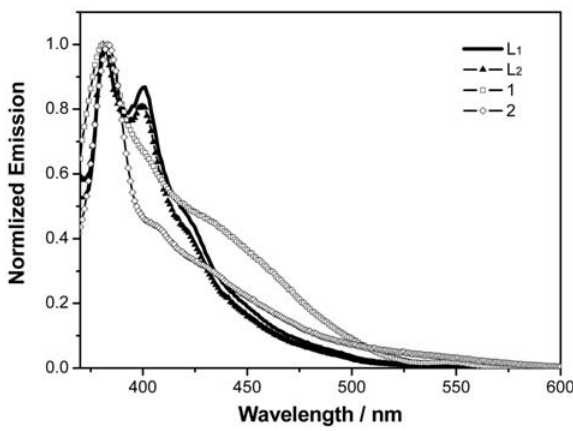
Fig. 2. Normalized emission spectra of ligands L xes 1 – 2 in CH